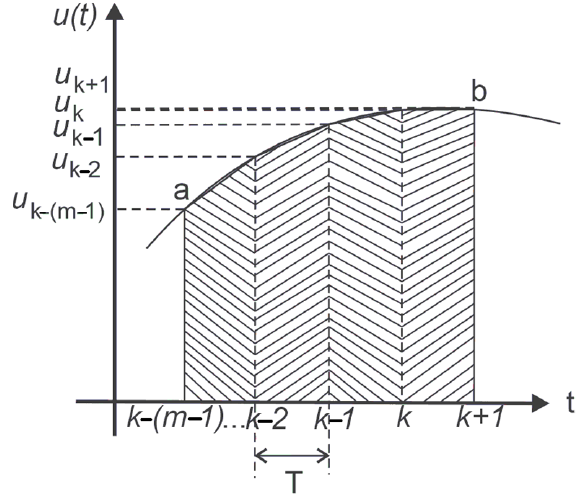
Figure 7. Compound trapezoidal principle.